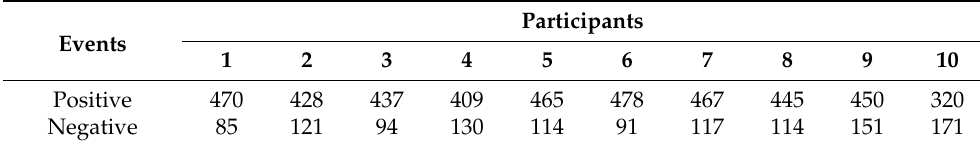
Table 5. Number of positive and negative events per participants.